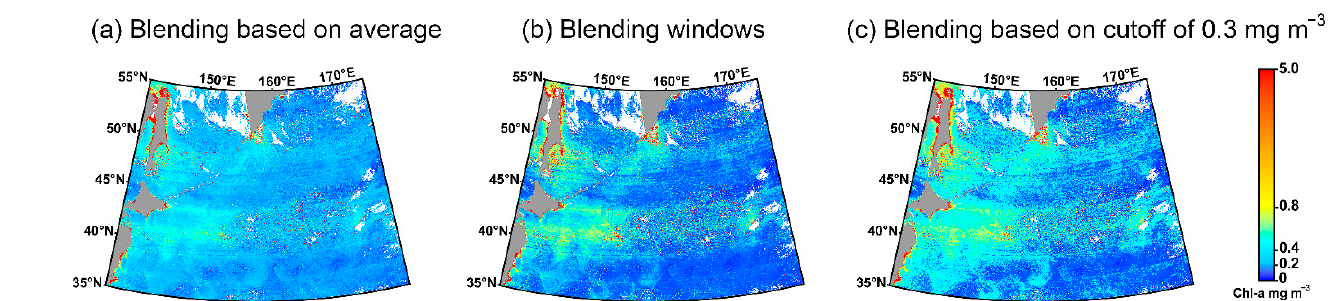
Figure 12. Example of Himawari-8 Chl-a retrieval algorithm blending. ( a ) is based on the averaging of Chl-a data generated by the two improved algorithms; ( b ) uses blending windows; ( c ) uses a cutoff of Chl-a = 0.3 mg m − 3 to blend the two improved algorithms.